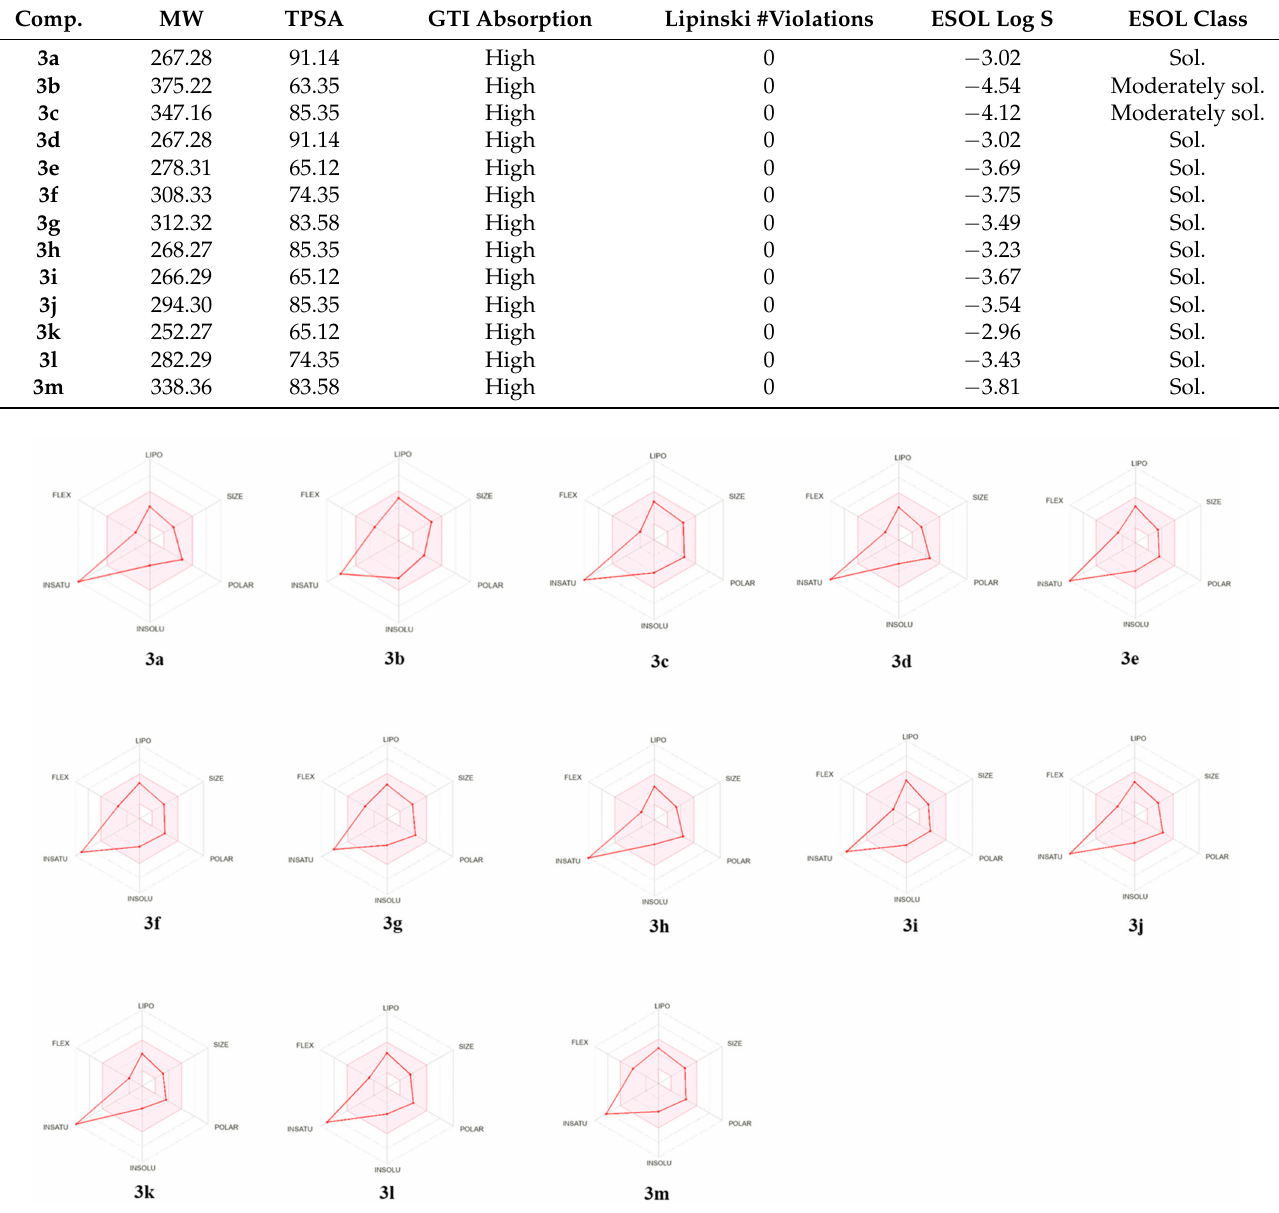
Figure 3. PK properties of the newly synthesized amides ( 3a – m ) predicted by the SwissADME platform. The predicted PK properties of all the newly synthesized indole-based